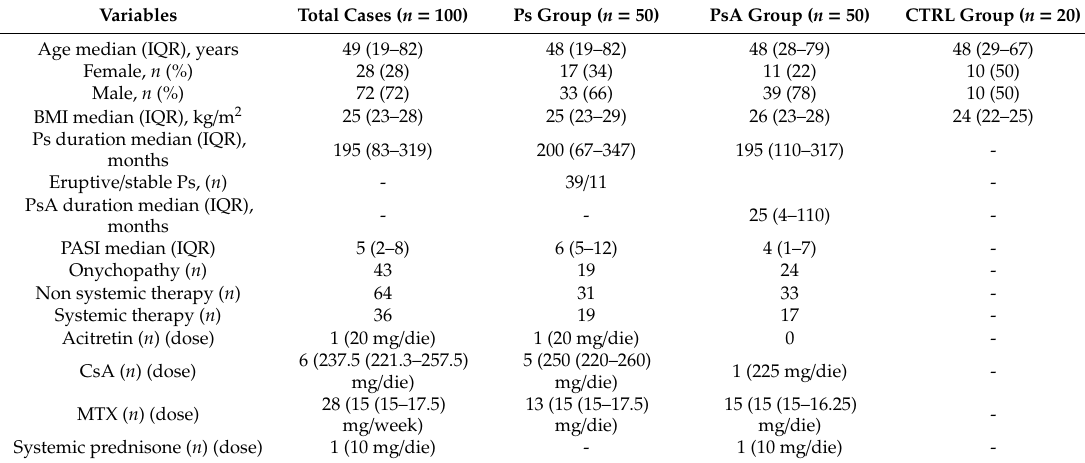
Table 1. Clinical features of patients at the time of